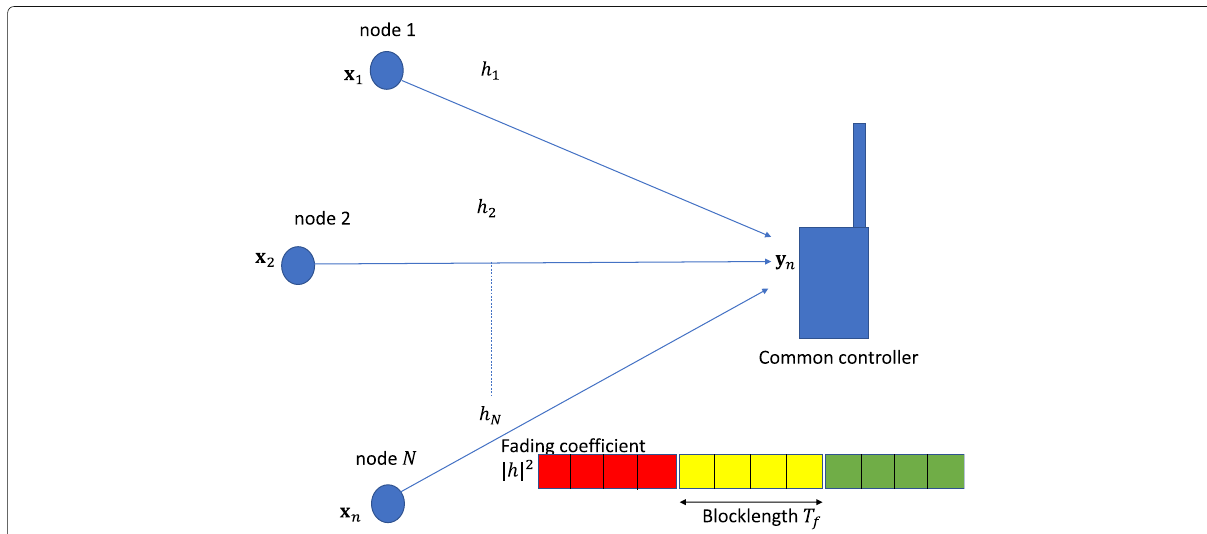
Fig. 1 Network layout. N machines communicating short packets to a common